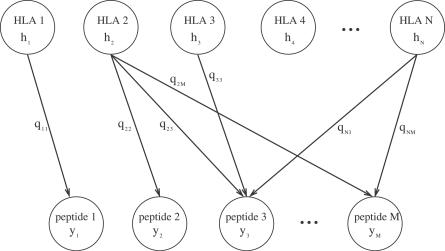
Graphical Depiction of HLA Restriction ModelGraphical depiction of the model used to infer HLA-restricted epitopes from ELISpot data. The probability of each peptide having a reaction is parameterized by a noisy-OR distribution over all of the HLA alleles it is connected to (Equations 1 and 2). The values of the HLA and peptide nodes are observed for each donor, and we are interested in finding which qij > 0—that is, which arcs are present in the graphical model. Each person has between three and six distinct HLA class 1alleles. Thus, for a given donor, between three and six HLA nodes will be “on” (hi = 1).